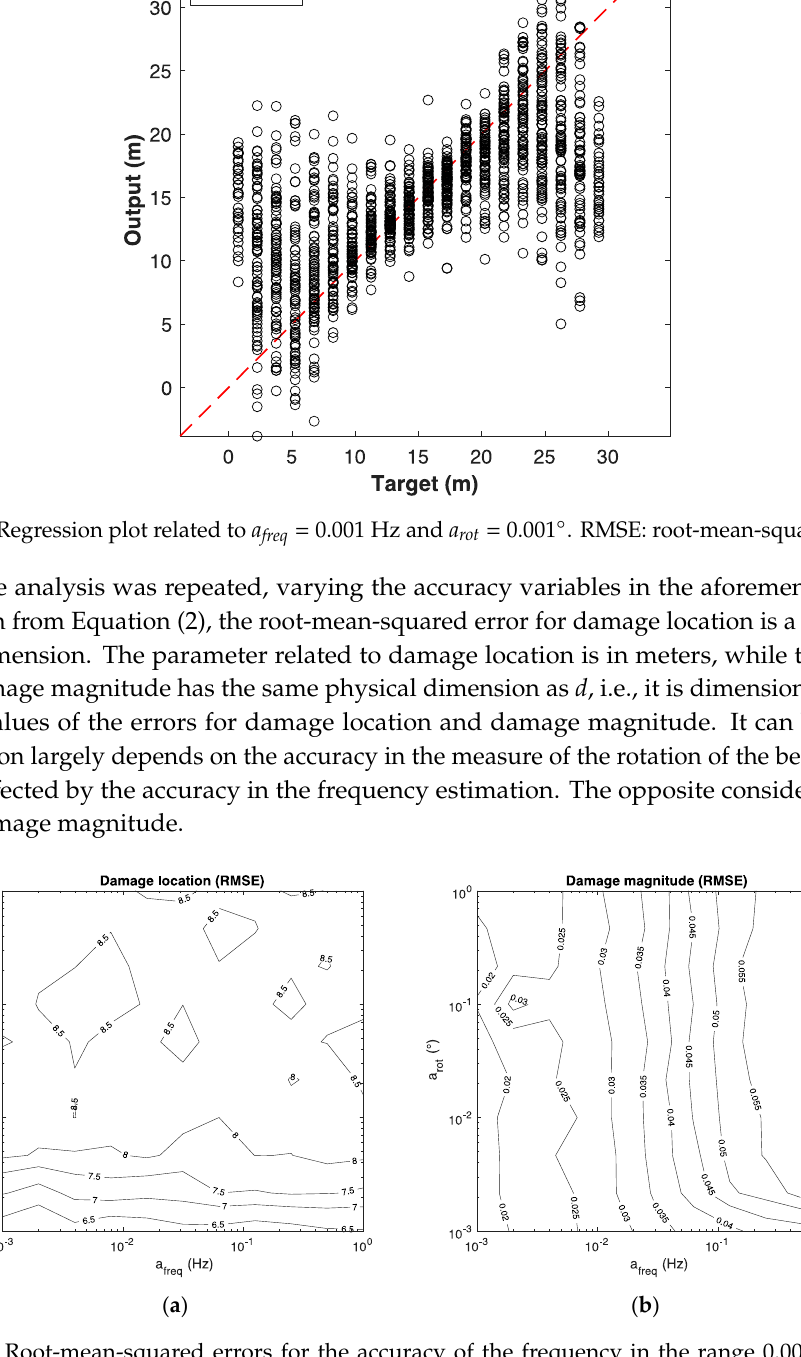
Figure 6. Root-mean-squared errors for the accuracy of the frequency in the range 0.001 Hz to 1 Hz and the accuracy of the rotation in the range 0.001° to 1°. In ( a ) the root-mean-squared error, in meters, related to damage location is proposed. In ( b ) the root-mean-squared error related to damage magnitude is reported.